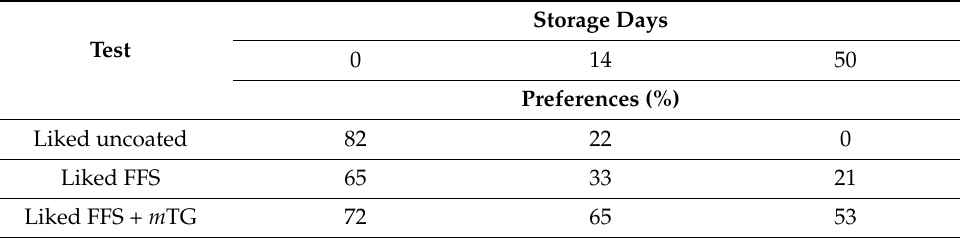
Table 3. Hedonic evaluation of general preference of uncoated and coated foods.